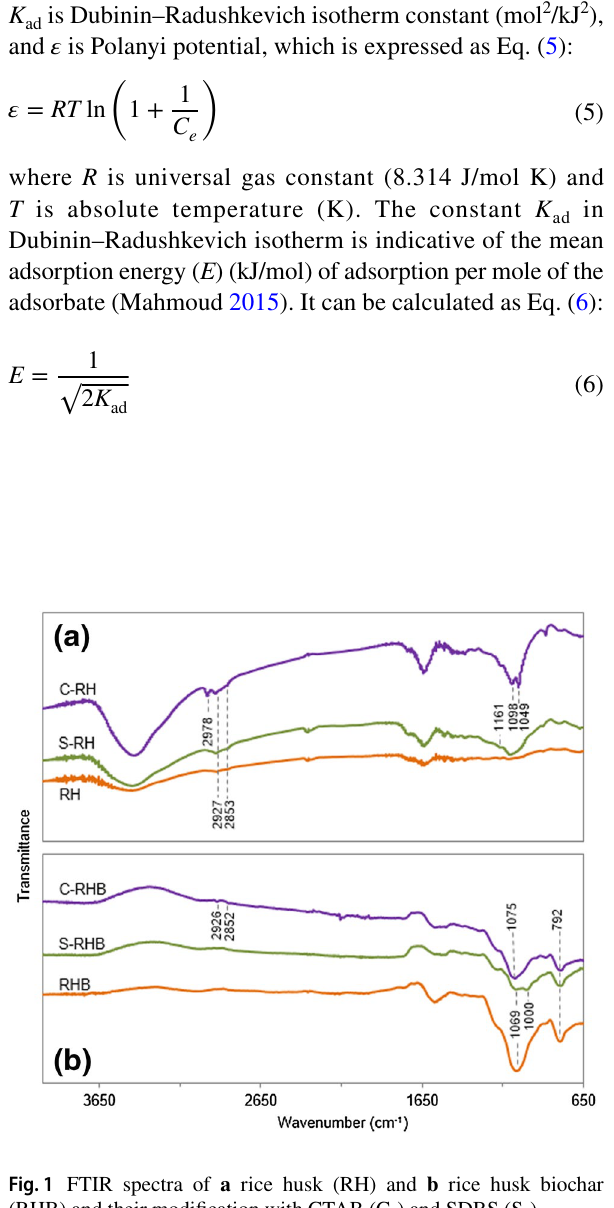
(RHB) and their modification with CTAB (C-) and SDBS (S-)